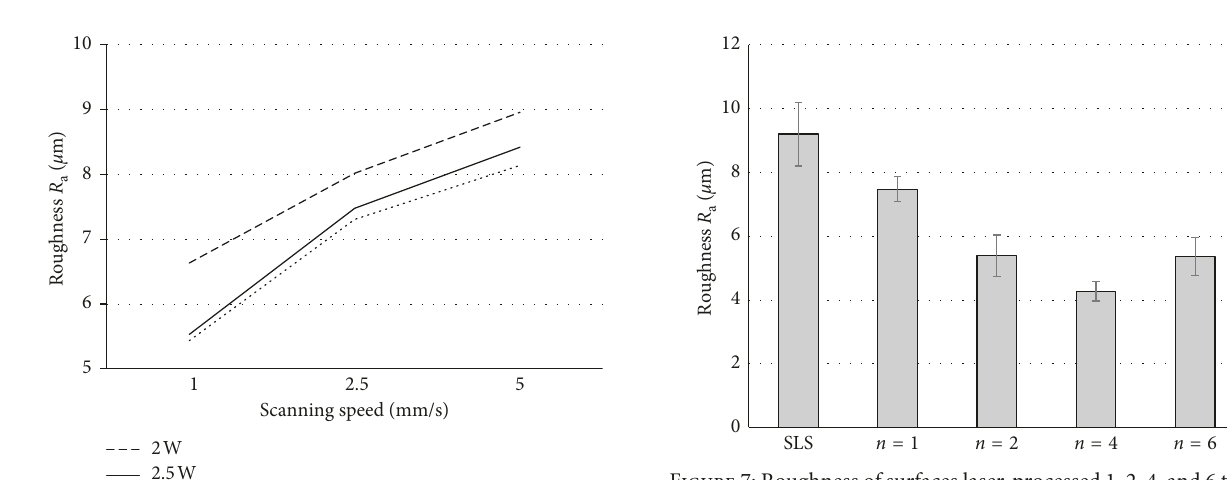
Figure 7: Roughness of surfaces laser-processed 1, 2, 4, and 6 times (2.5mm/s; 2.5 W). SLS: as-manufactured SLS